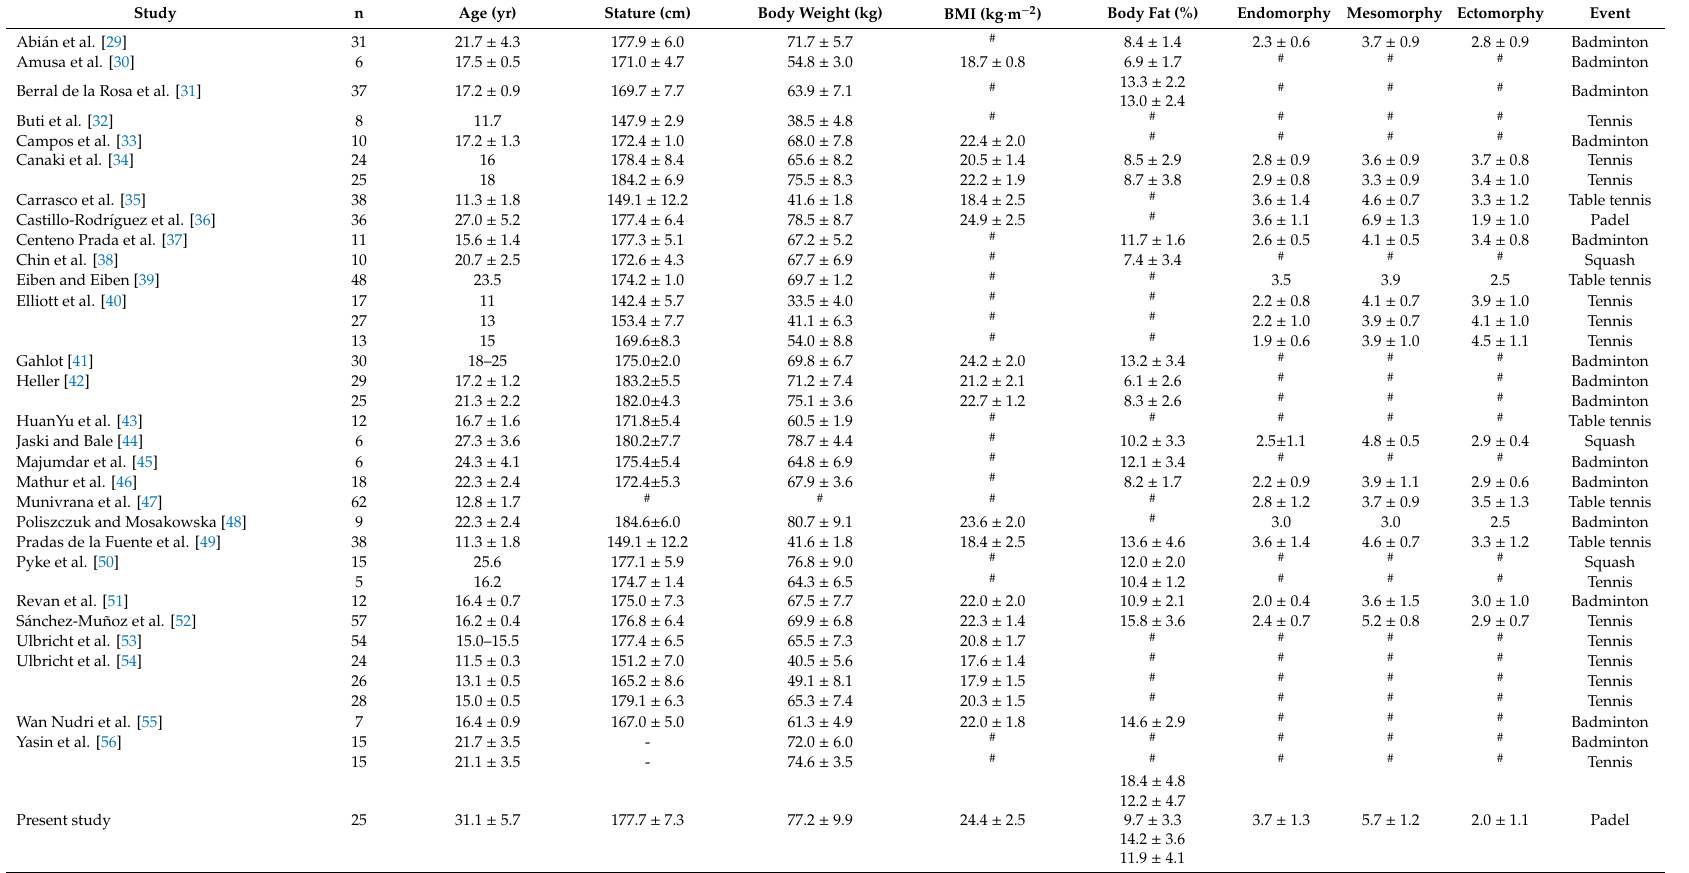
Table 3. Summary table of studies examining age, stature, body weight, body mass index (BMI), body fat percentage and somatotype of elite players of di ff erent racket sports (mean ±